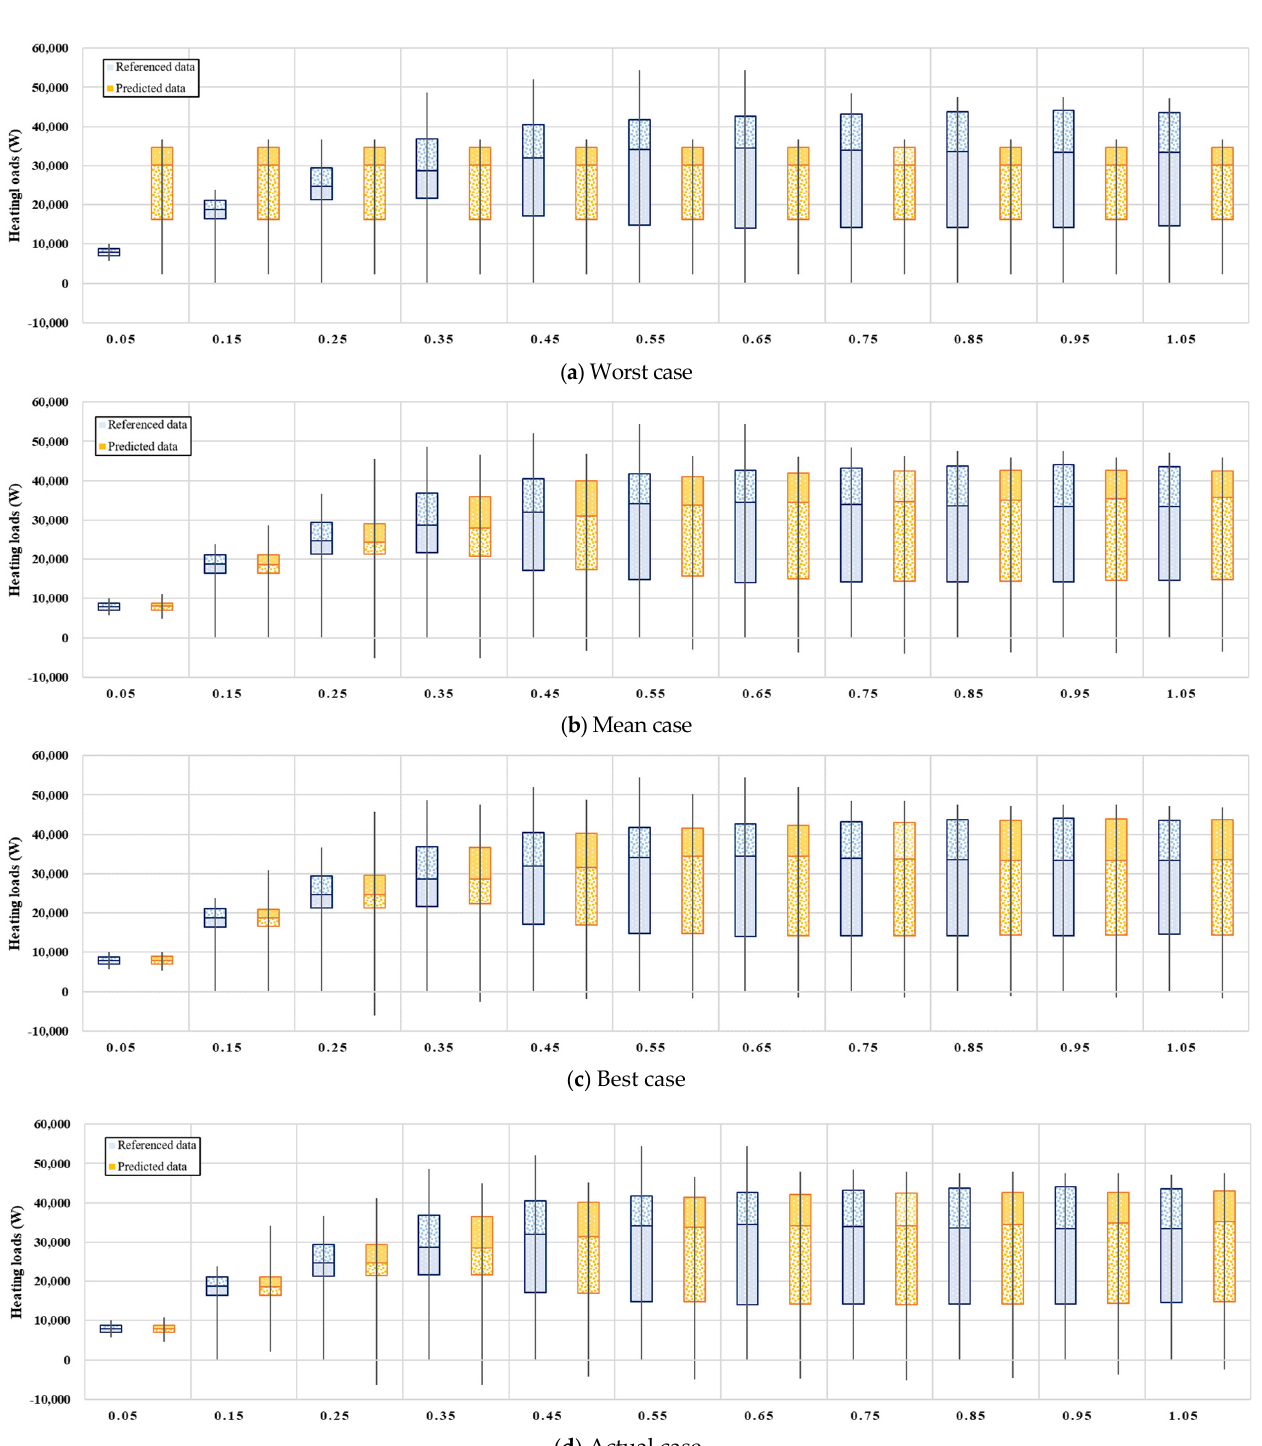
Figure 10. Distribution of the mass flow rate for the heating load.